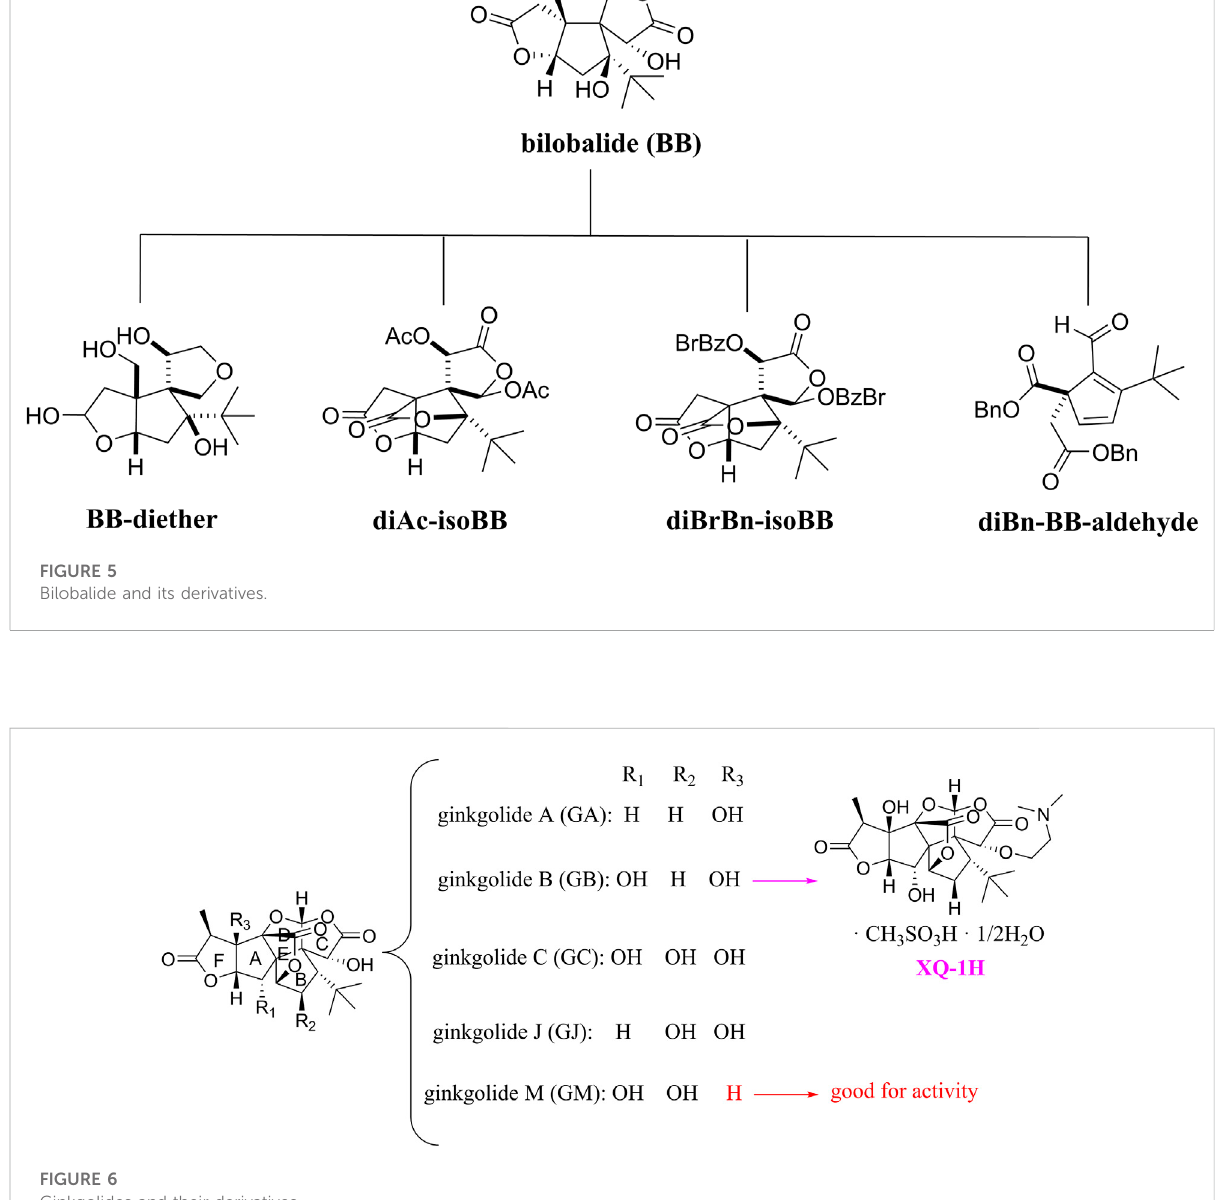
(Table1).TheSARanalysisrevealedtwoconclusions:1)substitution ofa2-isopropyl group onGAresultedinhighercellsurvivalthanthe substitution of a 2-methyl group in GA; 2) compounds with an electron-withdrawing group on the benzene ring showed better neuroprotective activity.